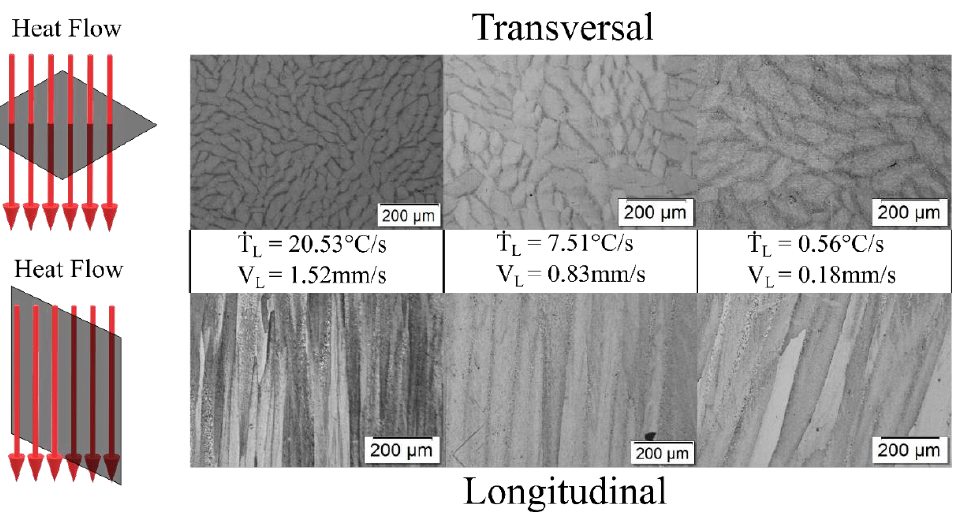
Figure 13. Typical microstructures along the length of the DS Zn-6 wt.% Al alloy casting. [ Ṫ L = cooling rate of liquidus isotherm, and V L = growth rate of liquidus isotherm].